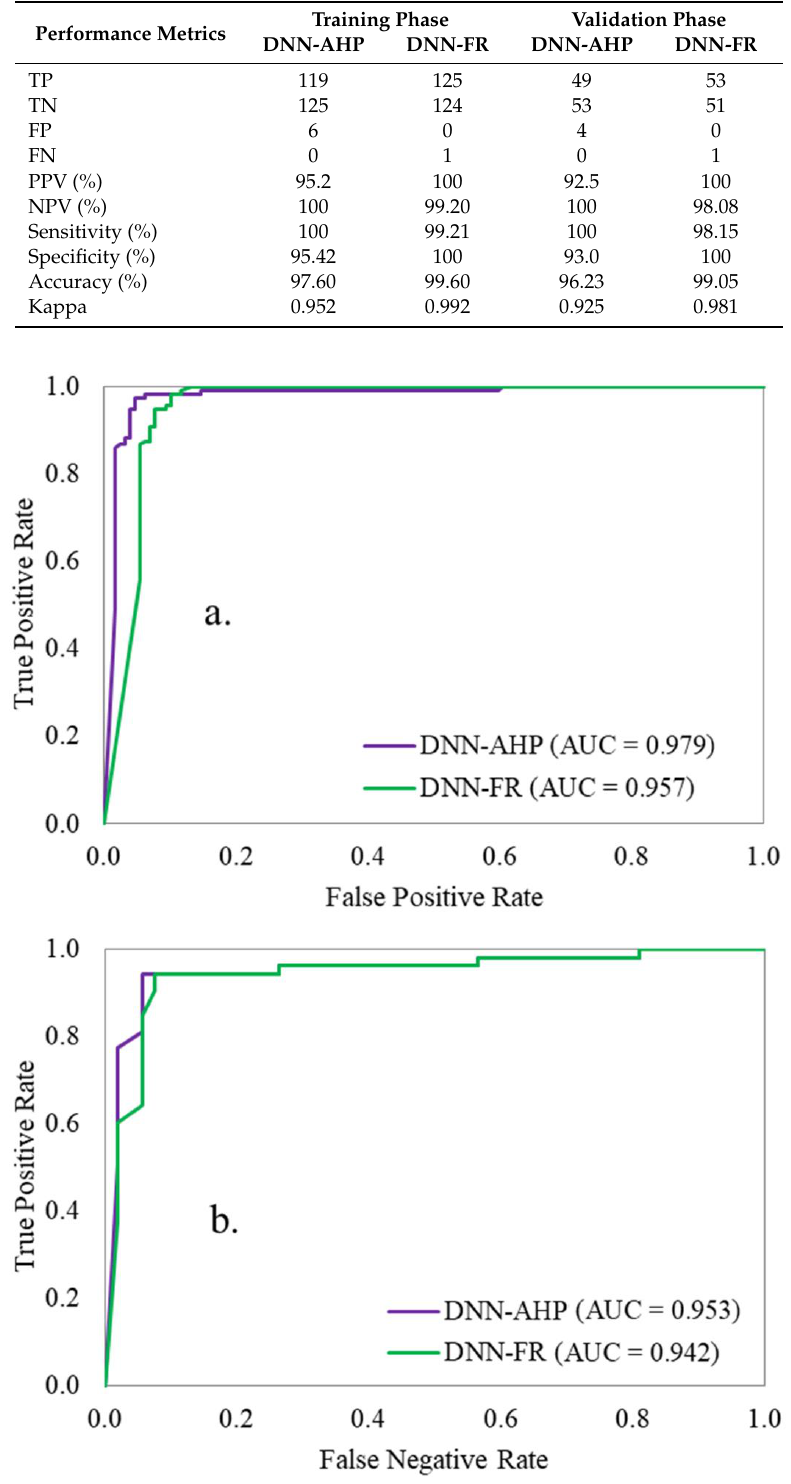
Table 3. Performance metrics of DNN-AHP and DNN-FR models.